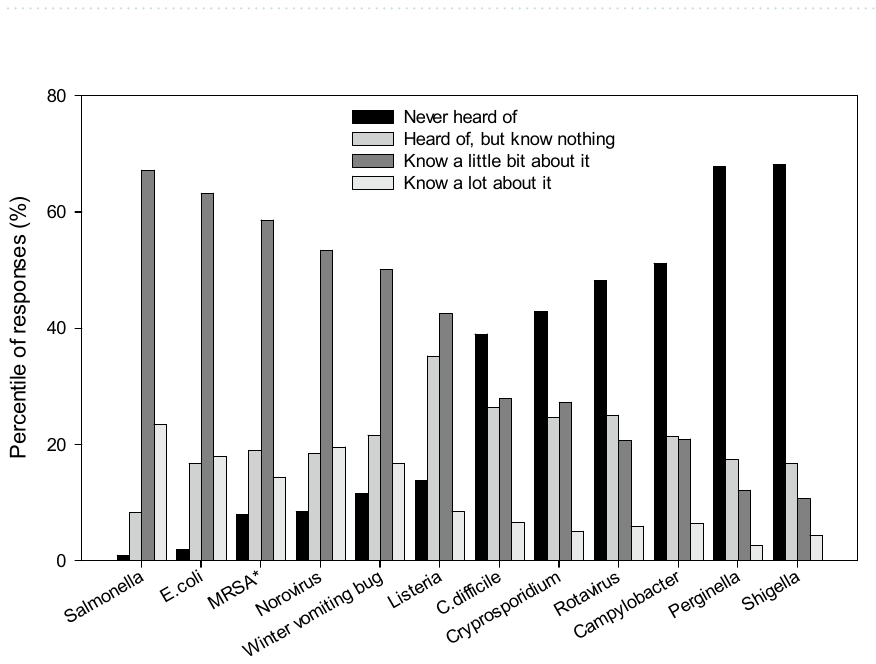
Figure 1. Respondents’ knowledge on pathogens causing gastroenteritis. *Methicillin-resistant Staphylococcus aureus